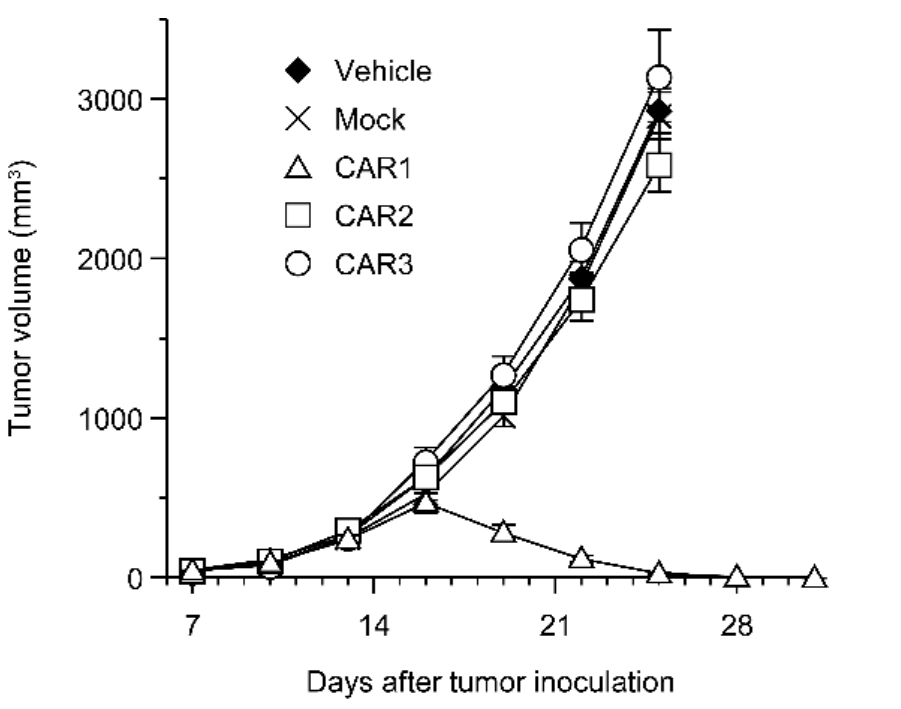
Figure 5. Anti-tumor effect of anti-Robo4 CARs against Robo4-expressing tumor. F1 (C57BL/6 × BALB/c) mice bearing mRobo4 + L1.2 tumors were intravenously injected with Robo4-specific CAR-T cells or mock-T cells at 5 × 10 6 cells/mouse on day 7 after tumor inoculation. Each point represents the mean ± SE of 6 mice.